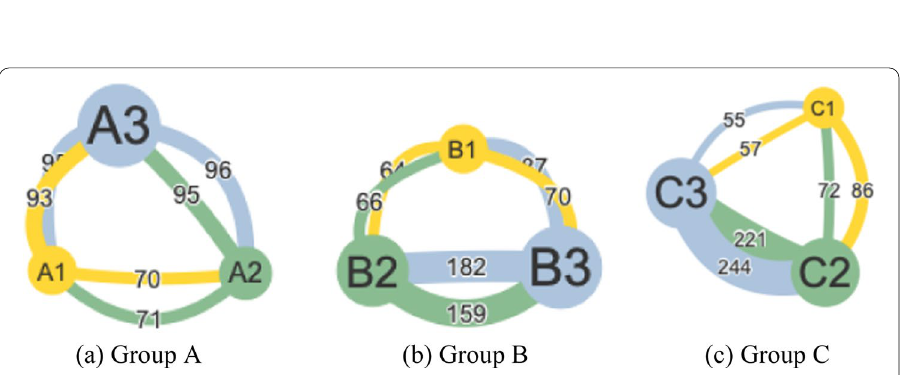
Fig. 4 Social interaction network of three groups. The node size represented interaction frequencies; the number on the tie represented the interaction a student had to another student; the direction of a tie should be read from the node with the same color of the tie to the node with a different color (e.g., C3 sent 244 replies to